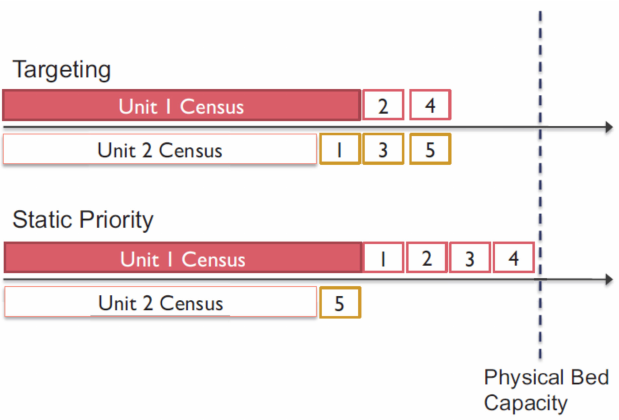
Figure 10. Two possible placement